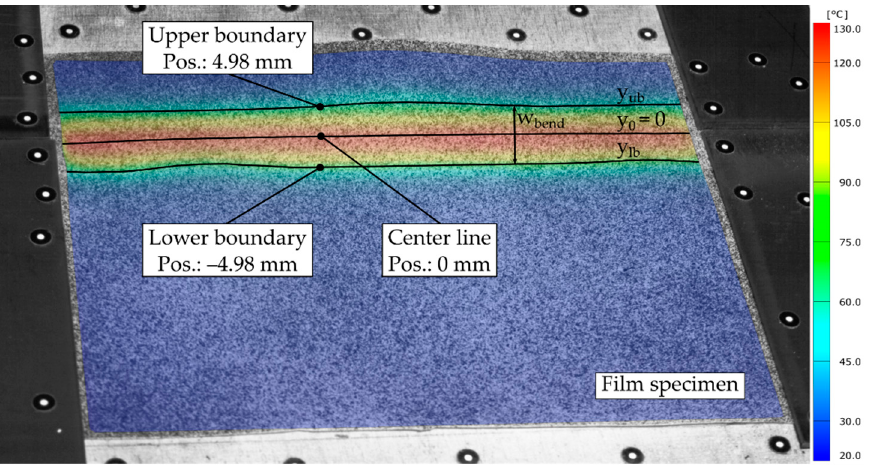
Figure 10. Temperature distribution on the upper surface of the film specimen and position of the measurement sections along the center as well as the upper and lower boundaries of the bending area one time step before initiating the bending procedure (test No. 9, t = 20.0 s). To identify favorable process parameter ranges, the temperatures along the center line and the upper y ub = w bend and lower y lb = − w bend boundary of the bending area had 2 2